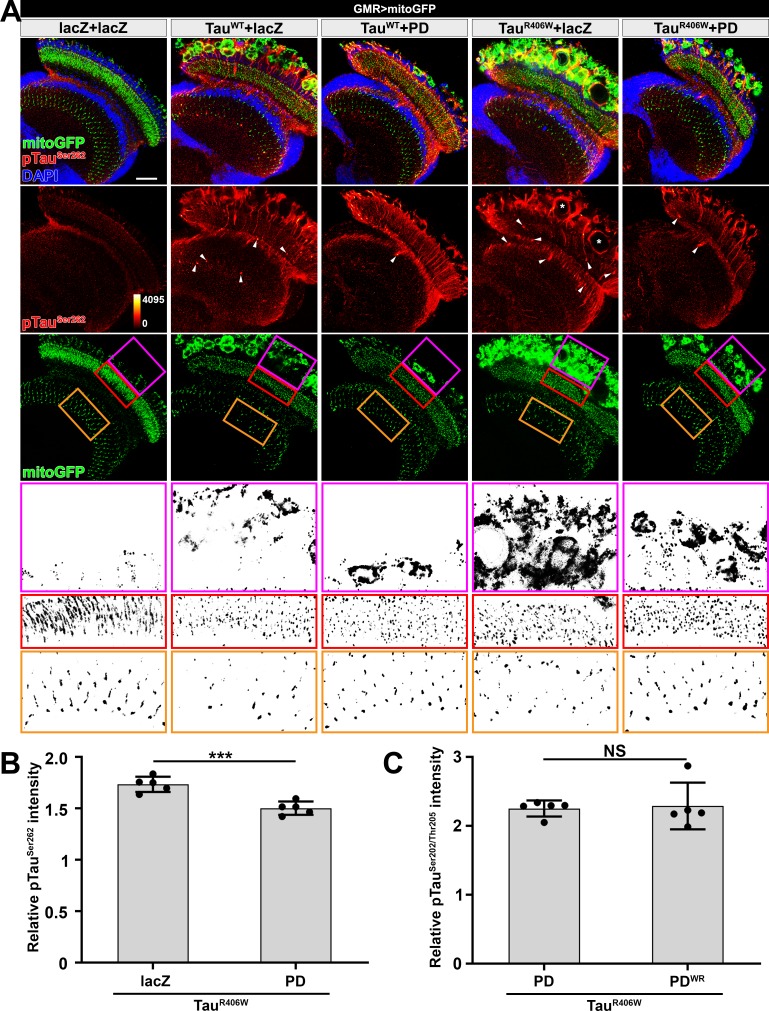
Drosophila NMNAT(PD) suppresses pTau-induced mitochondrial clustering.(A) Adult female Drosophila (2 DAE) brains expressing mitochondrial marker mitoGFP (green) together with lacZ+lacZ, TauWT+lacZ, TauWT+PD, TauR406W+lacZ, or TauR406W+PD under GMR-GAL4 were stained for pTau (red spectrum) and DAPI (blue). White arrowheads show the aggregation of pTau. White asterisks show the holes formed in the lamina cortex layer. Magenta, red, and yellow boxes indicate the lamina cortex, lamina, and medulla layers, respectively. Scale bar, 30 µm. (B) Quantification of pTauSer262 intensity in the lamina and lamina cortex in A. Data are presented as mean ± s.d., with n = 5. Independent samples t-test; ***p<0.001. (C) Quantification of pTauSer202/Thr205 intensity in the lamina and lamina cortex in Figure 4A. Data are presented as mean ± s.d., with n = 5. Independent samples t-test; NS: not significant.